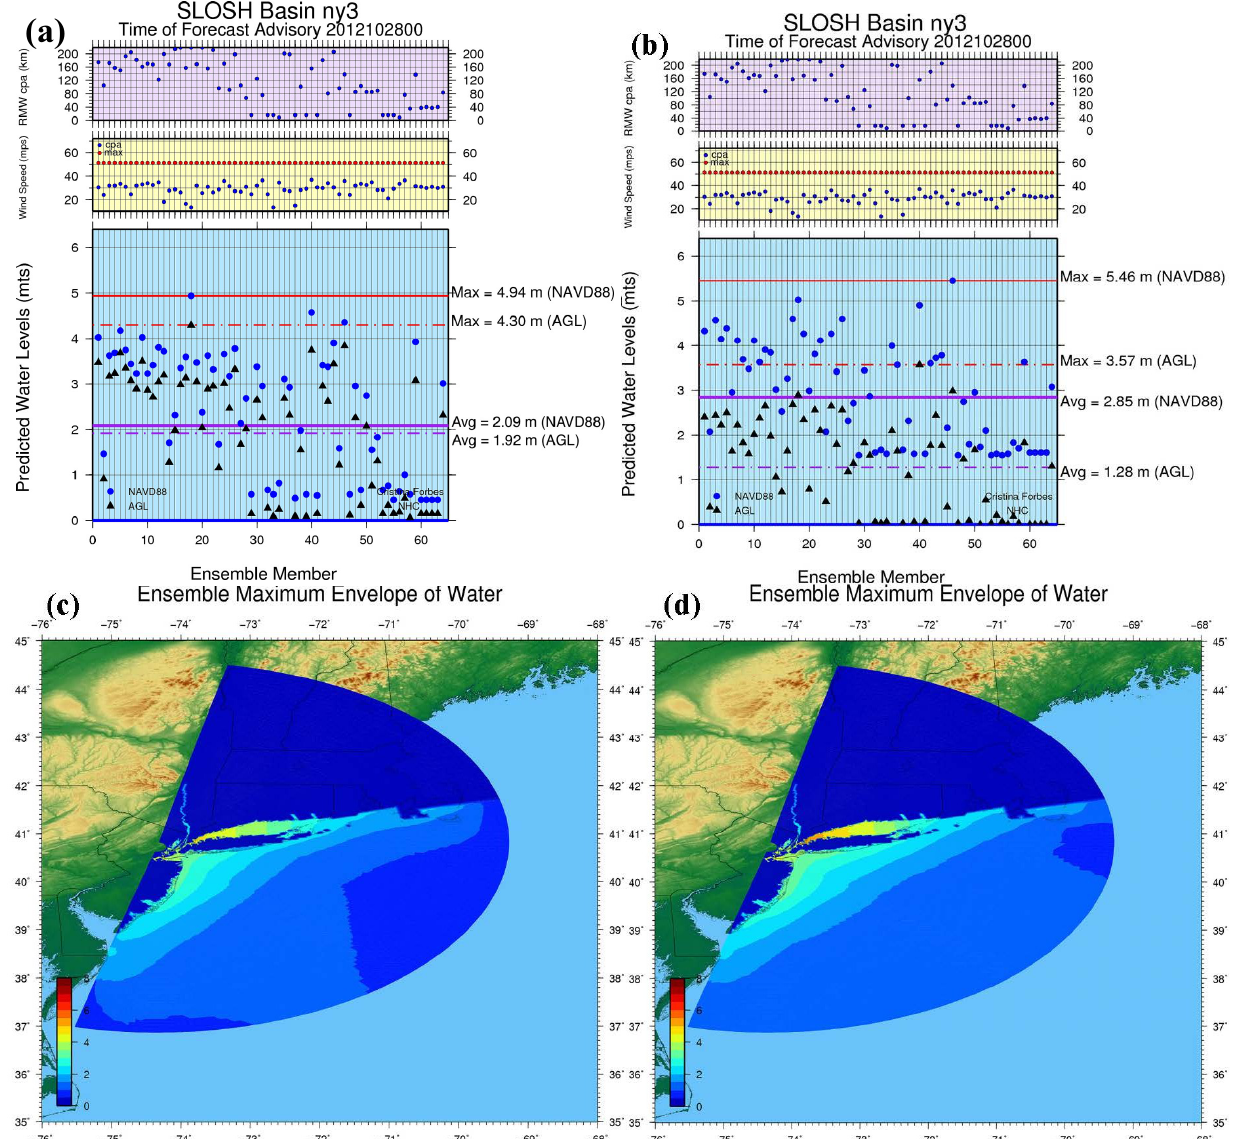
(2012) valid 48 h prior to landfall: ( a ) for surge and ( b ) for surge + tides. Ensemble maximum envelope of water for ( c ) surge and ( d ) surge + tides 48 h prior to landfall with maximum total water levels of 4.94 m and 5.46 m, respectively (relative to the NAVD88 vertical